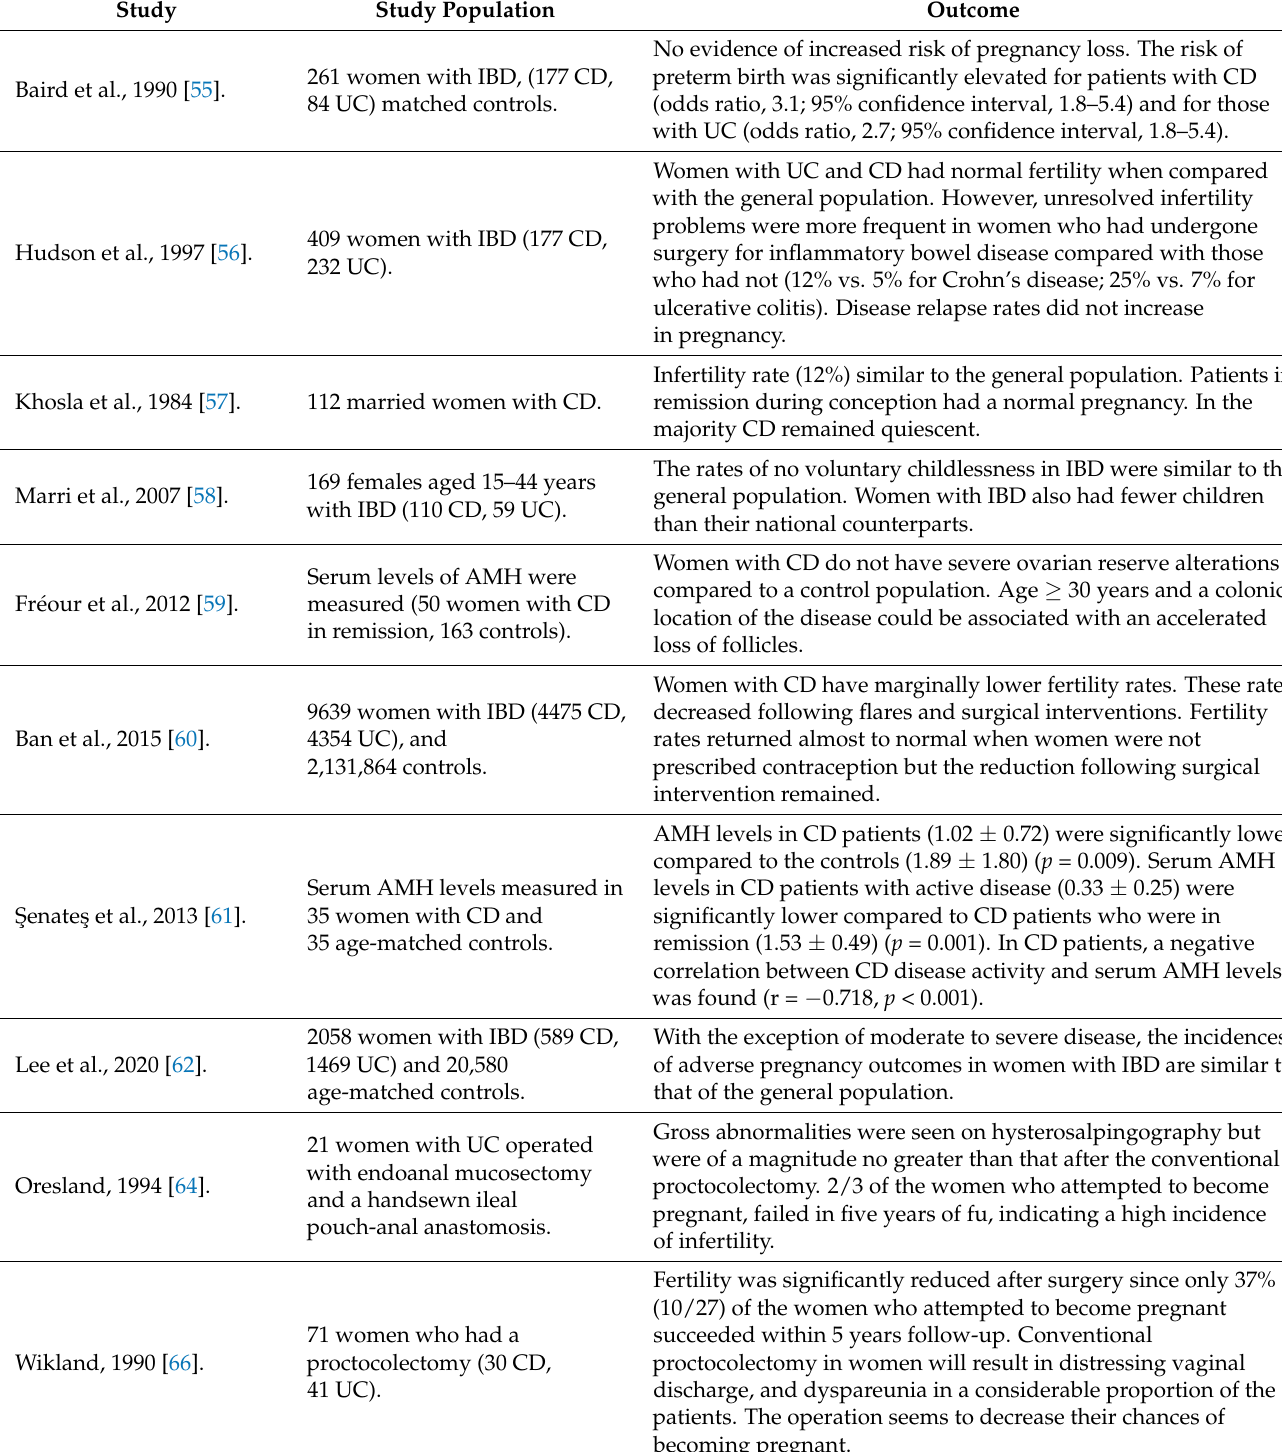
Table 3. Studies evaluating the effect of IBD on women’s fertility and